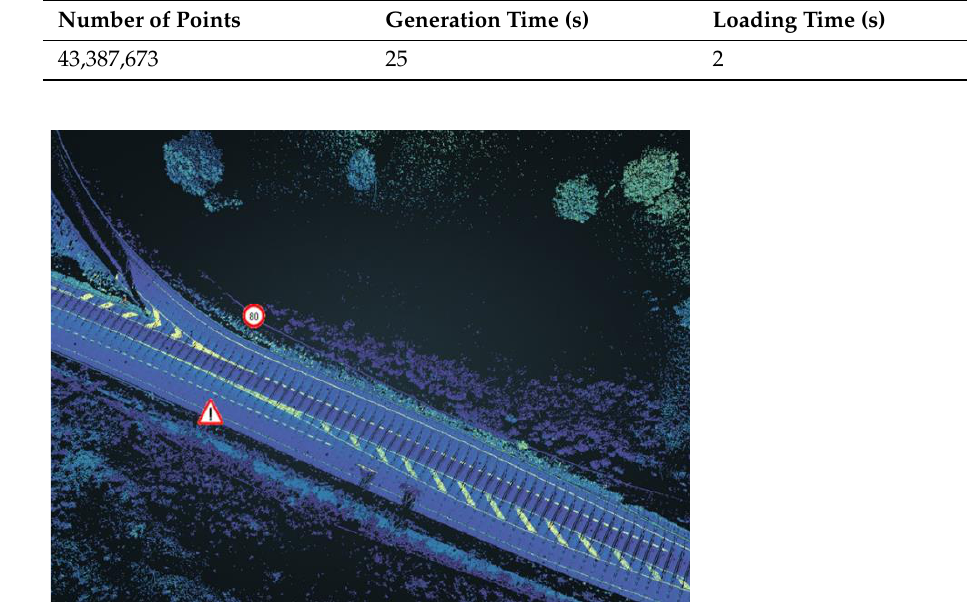
Figure 12. 3D visualization of the classified traffic signs using Potree.